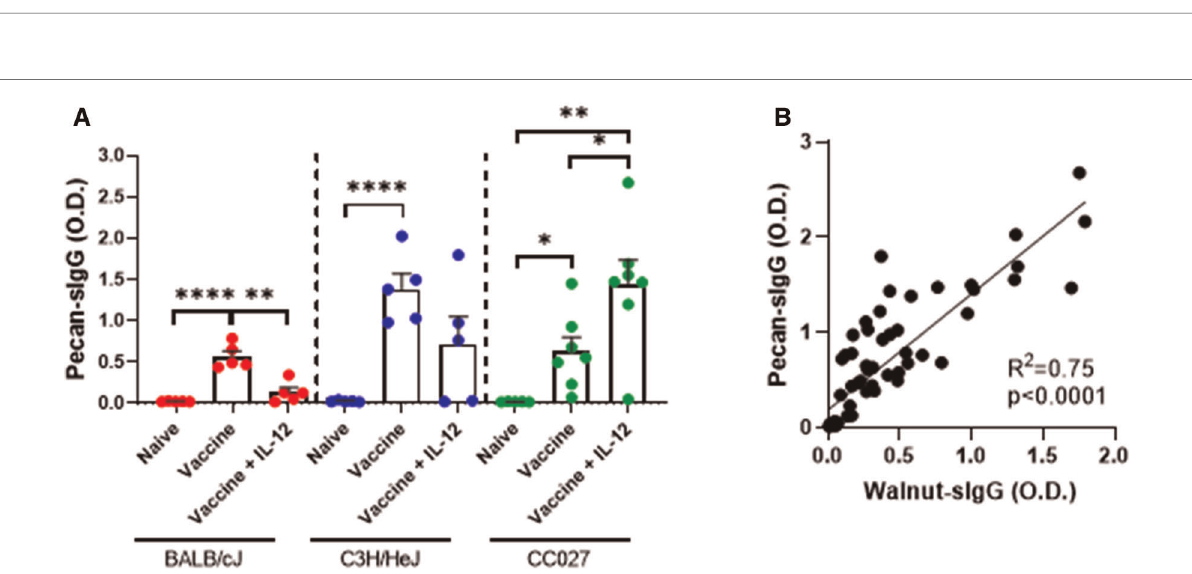
FIGURE 5 Pecan-speci fi c IgG responses following DNA vaccination with Gene Gun. ( A ) Pecan-speci fi c IgG quantities in naïve and vaccinated BALB/cJ, C3H/ HeJ, and CC027 mice. ( B ) Correlation between walnut- and pecan-speci fi c IgG responses. Statistical comparisons were made using unpaired t tests; * p <0.05, ** p <0.01, **** p <0.0001. Linear regression analysis was performed on the correlation